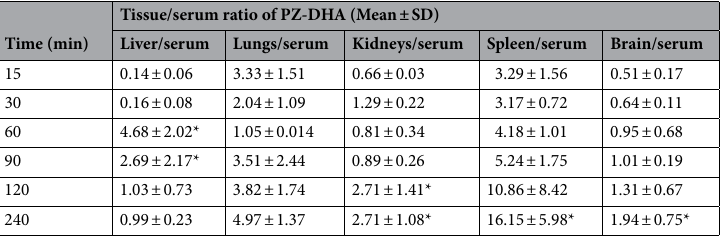
Table 2. Tissue/serum concentration ratio for PZ-DHA in Balb/c female mice. Tissue/serum concentration ratios for PZ-DHA were compared at each time point, considering 15 min as the baseline (n = 4). * p <